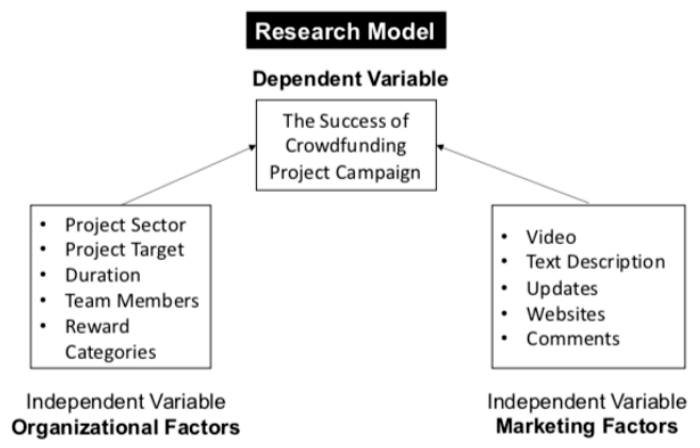
Figure 1. Research model. Table 1. Operationalization.